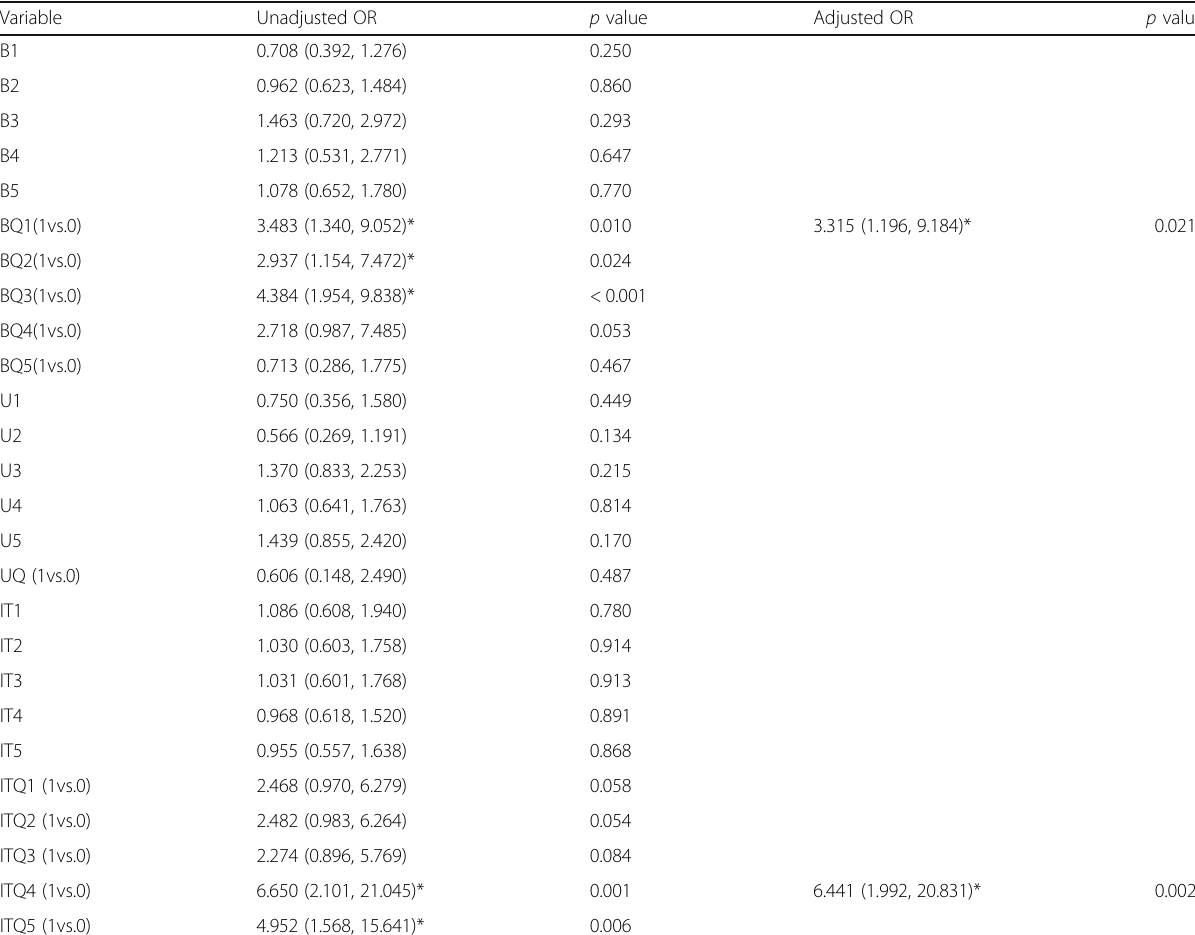
Table 6 Future confidence and capacity logistic regression result